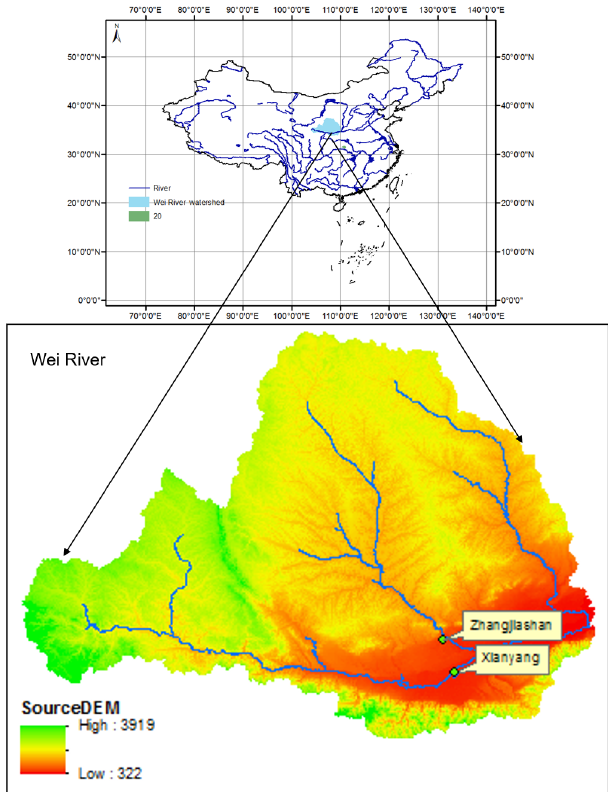
Figure 2. The location of the studied watersheds. The Wei River is the largest tributary of the Yellow River, with a drainage area of 135000km 2 . The historical flood data from the Xianyang and Zhangjiashan stations on the Wei River are analysed through the proposed IFC